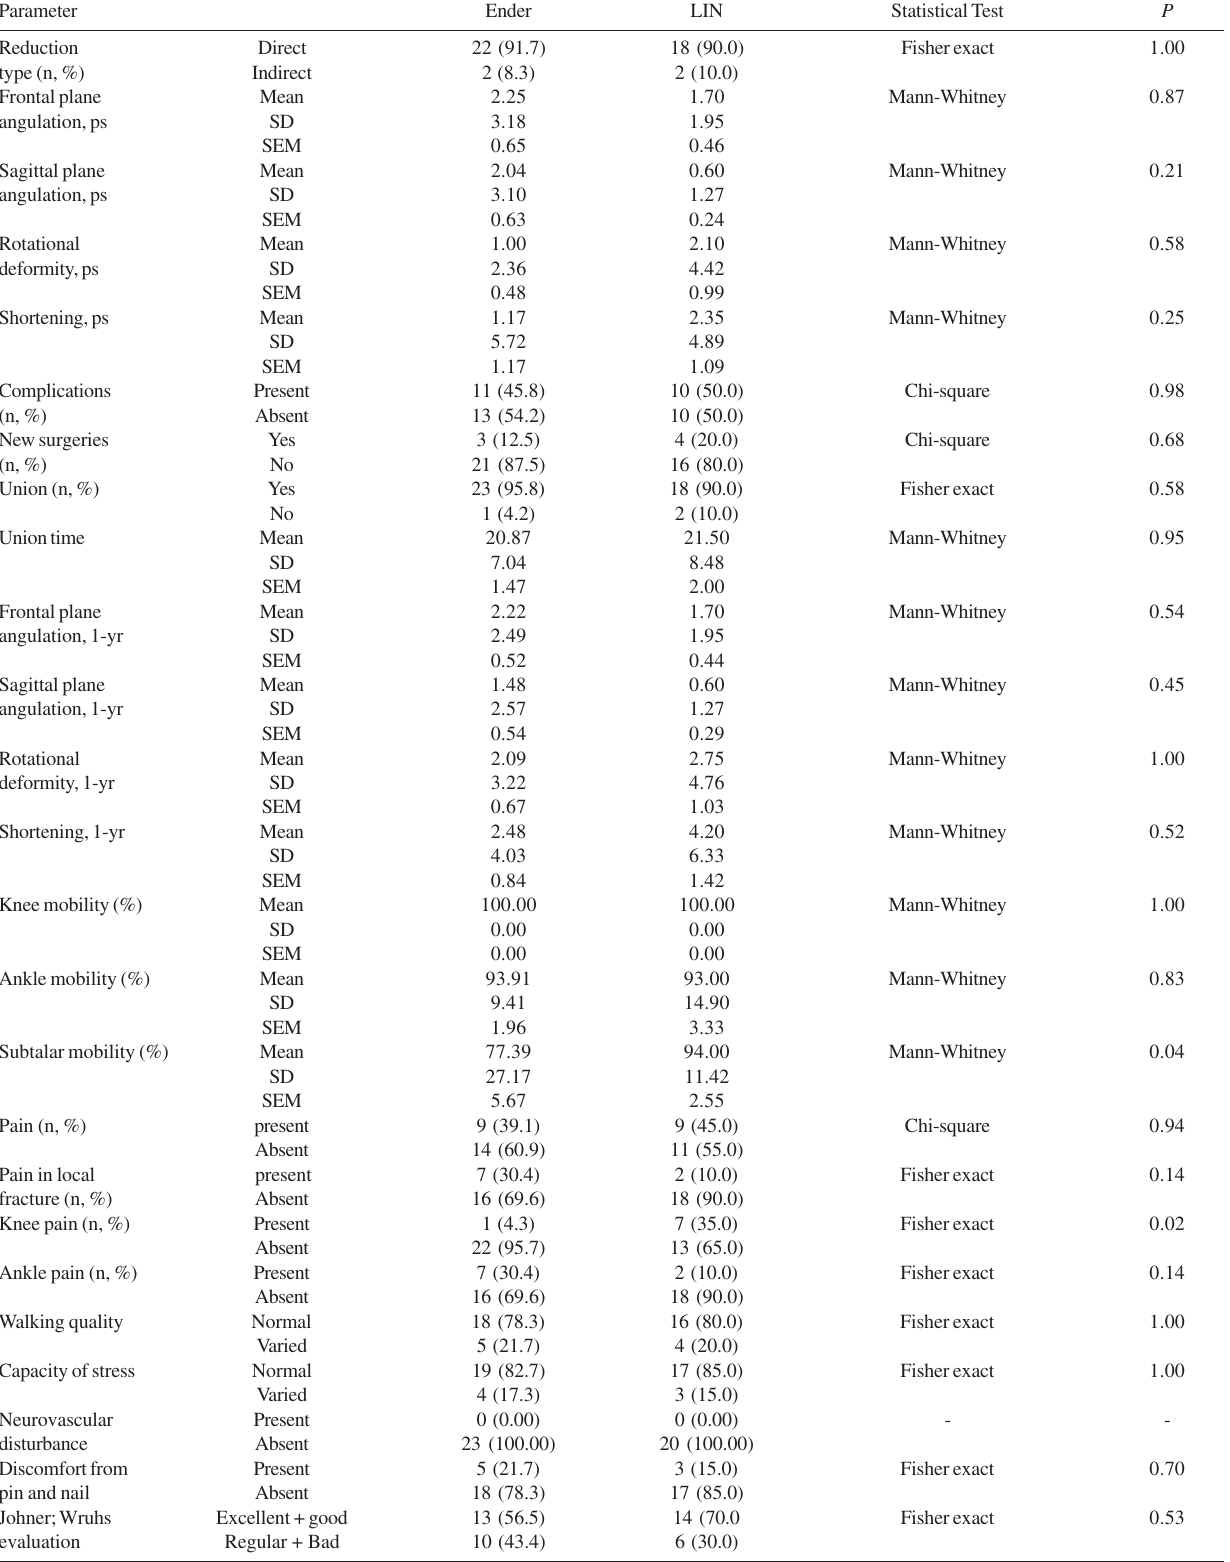
Table 3 - Tabulation of the immediate postsurgical (ps) evaluation and 1-year (yr) follow-up results. Parameter Ender LIN Statistical Test